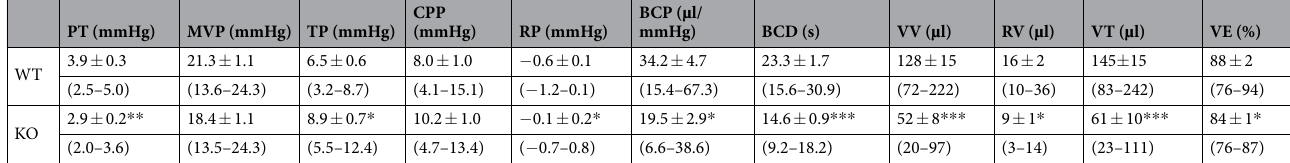
Table 1. Comparisons between WT and P2Y 6 -KO mice with respect to cystometric parameters during the reflex micturition cycle. PT, pressure at volume threshold for inducing micturition contraction; MVP, maximal voiding pressure; TP, trough pressure; CPP, closing peak pressure; RP, post-void resting pressure; BCP, bladder compliance; BCD, bladder contraction duration; VV, voided volume; RV, post-void residual volume; VT, volume threshold for inducing micturition contraction; VE, voiding efficiency. Numbers in parentheses are ranges. Significant difference from variable of WT mice: * P < 0.05, ** P < 0.01, *** P < 0.001 (unpaired t-test or Mann-Whitney U test, according to the result of D’Agostino & Pearson omnibus normality test). Values are expressed as the mean ± SEM (n = 10 for each).